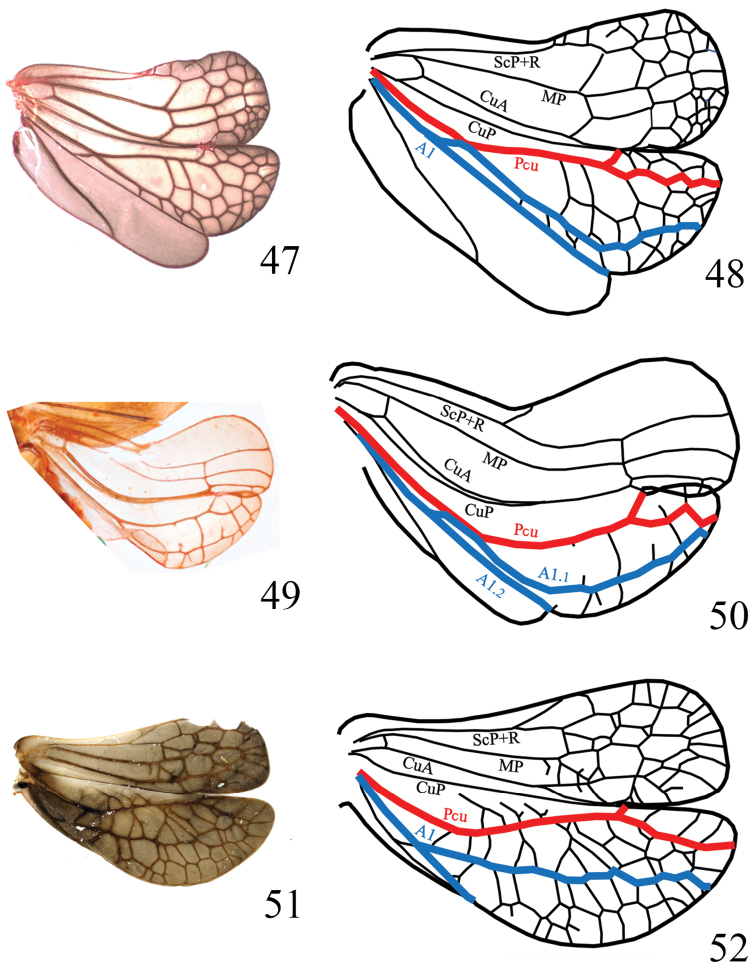
Hindwing pattern and venation. 47, 48Scantiniina subtrib. nov.: Scantinius
bruchoides (Walker, 1858) (modified from Gnezdilov 2012, fig. 3) 49, 50Vindilisina subtrib. nov.: Vindilis
fornicata Stål, 1870 (modified from Gnezdilov 2018, fig. 3) 51, 52Parahiraciina Cheng & Yang, 1991 subtrib. nov.: Tetricodes
tamdaoensis Vanslembrouck & Constant, 2018 (modified from Vanslembrouck and Constant 2018, fig. 4).